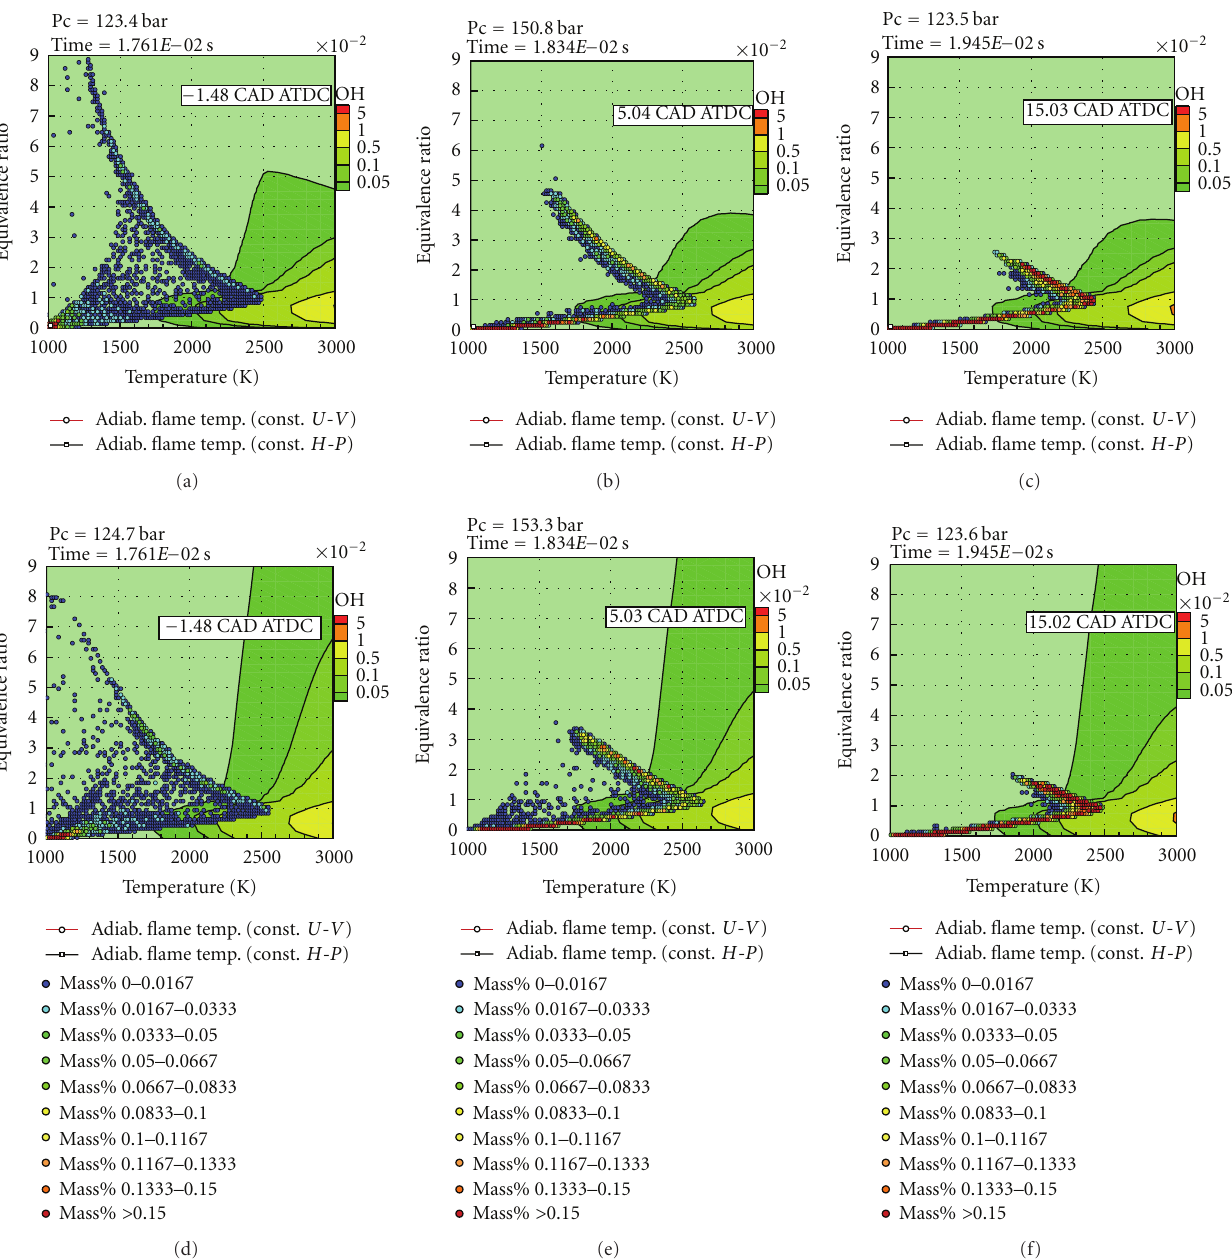
combustion really has a leaner combustion, the equivalence ratio distribution in the diesel engine cylinder was presented for both diesel oil and RME at the same CADs instants as Figure 12, see Figure 13. One can overlap the NO contour and equivalence contour and find out the highest NO concentration region locates at φ (0 . 6 ∼ 1 . 8) under the diesel engine operating conditions. For the too high (red color) or too low (blue) equivalence ratio region, there is no NO formed (colored by blue) in Figure